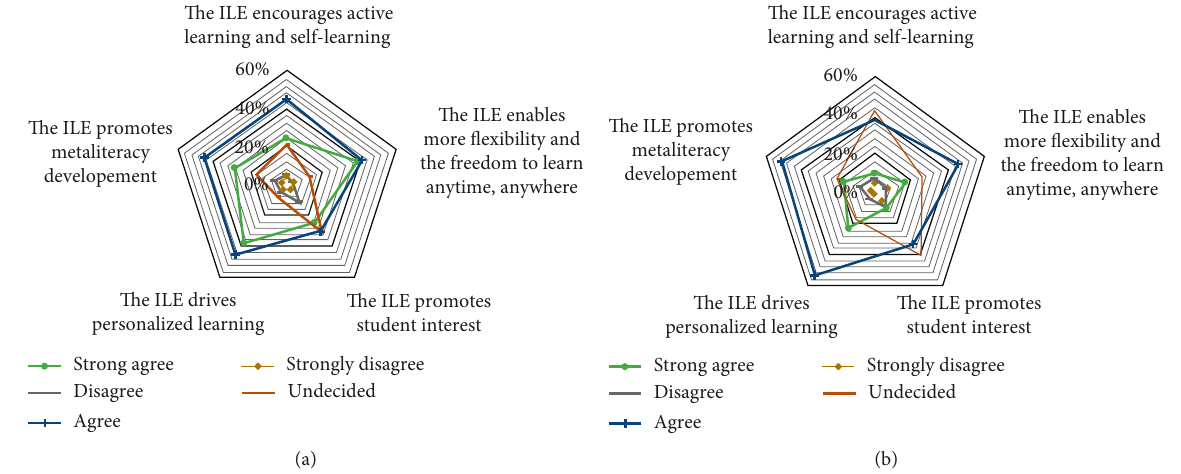
Figure 6: Learner reflections. Benefits of integrating practices of metaliteracy with blended learning: (a) CST students’ responses and (b) ELL students’ responses.